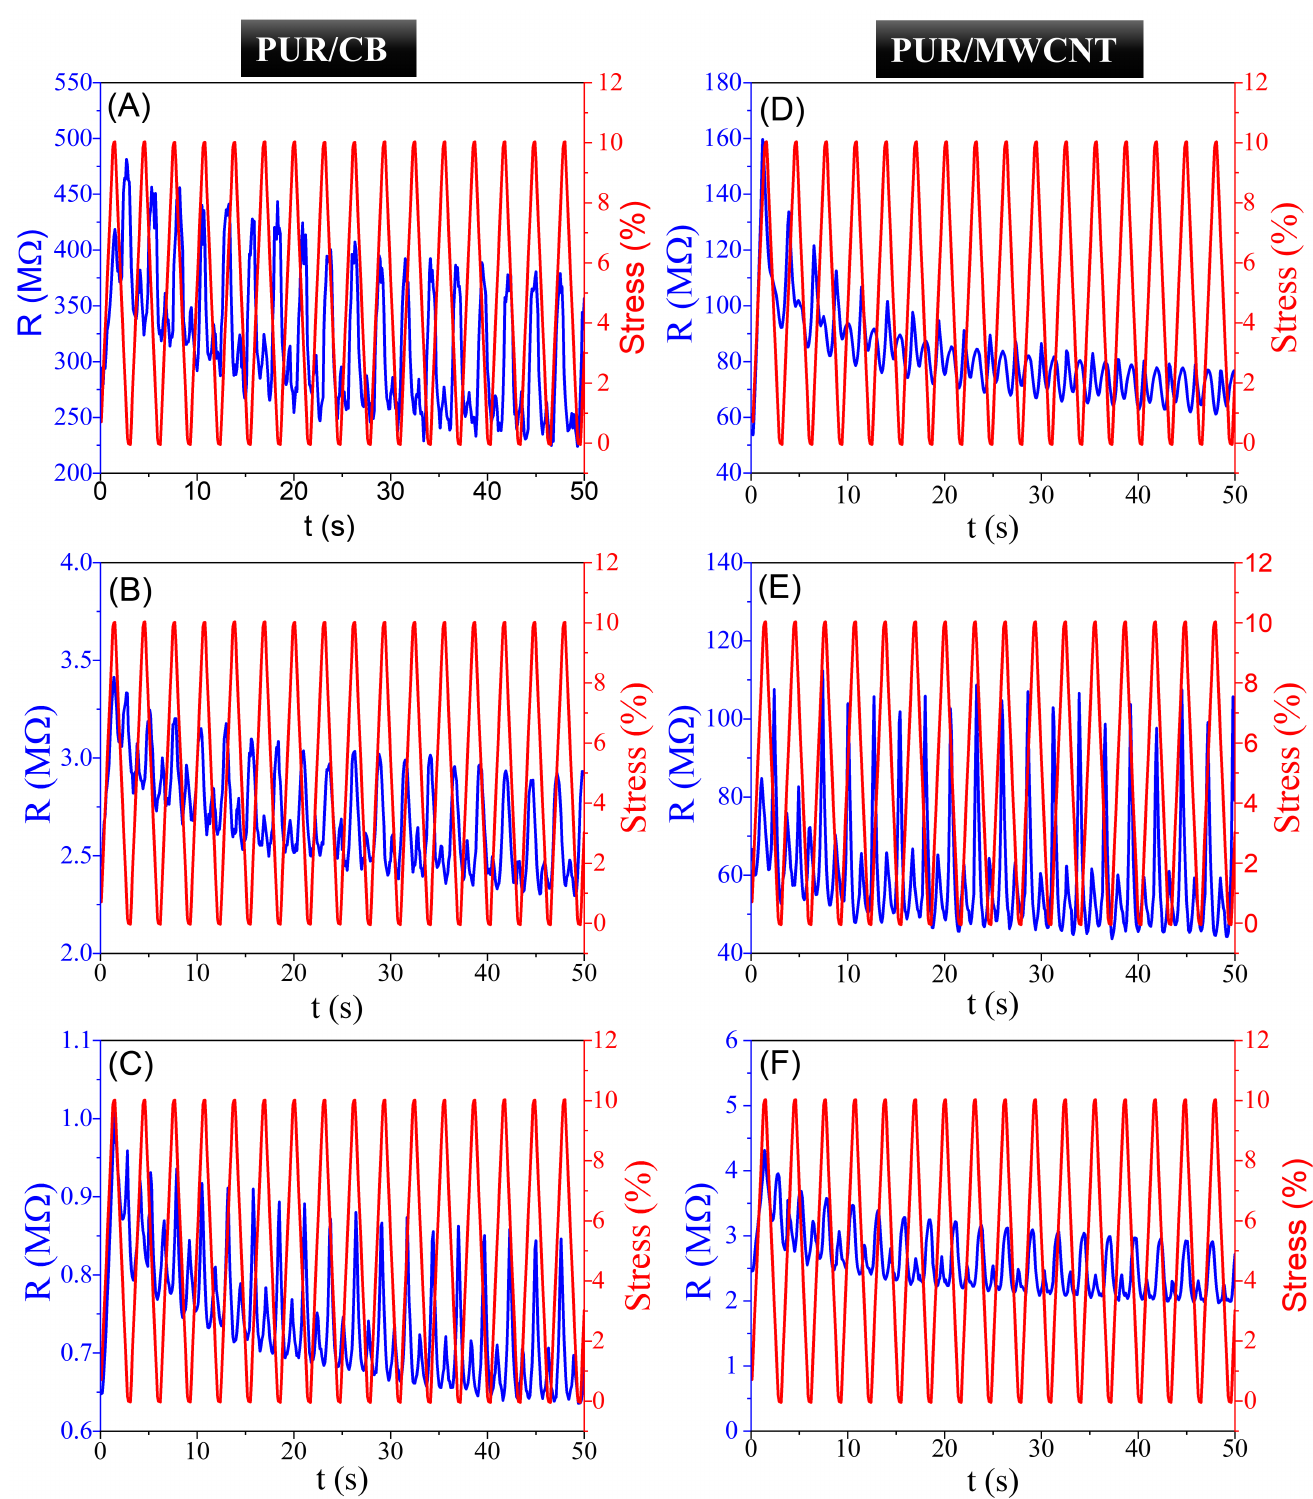
Figure 6. Piezoresistive response of ( A – C ) PUR/CB and ( D – F ) PUR/MWCNT nanocomposite with 3, 4 and 5 mass% for 10% of strain and 16